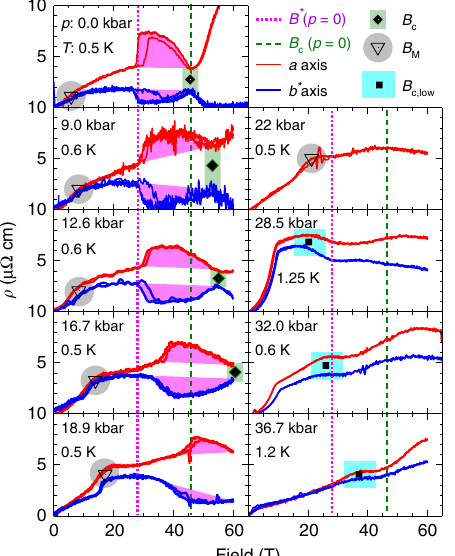
Fig. 2 Pressure dependence of the magnetoresistivity at base temperature. MR recorded at lowest temperatures for sample 2 at different pressures ( p = 0 kbar was recorded for sample 1), red and blue correspond to fi eld pulses that overlay the up- and down-sweep data for the I ∣∣ a - and I ∣∣ b * -direction, respectively. The magenta dotted line marks the zero- pressure onset fi eld of the nematic phase, B * ( p = 0), and the green dashed line the zero-pressure AFM suppression fi eld, B c ( p = 0). Magenta shaded areas highlight the nematic resistivity anisotropy above B * . Green diamonds mark B c ( p ). Gray hollow triangles mark the well-known metamagnetic transition at B M (see text). Blue squares mark a new feature we associate with fi eld-induced magnetism, due to its temperature dependence (see text related to Fig.